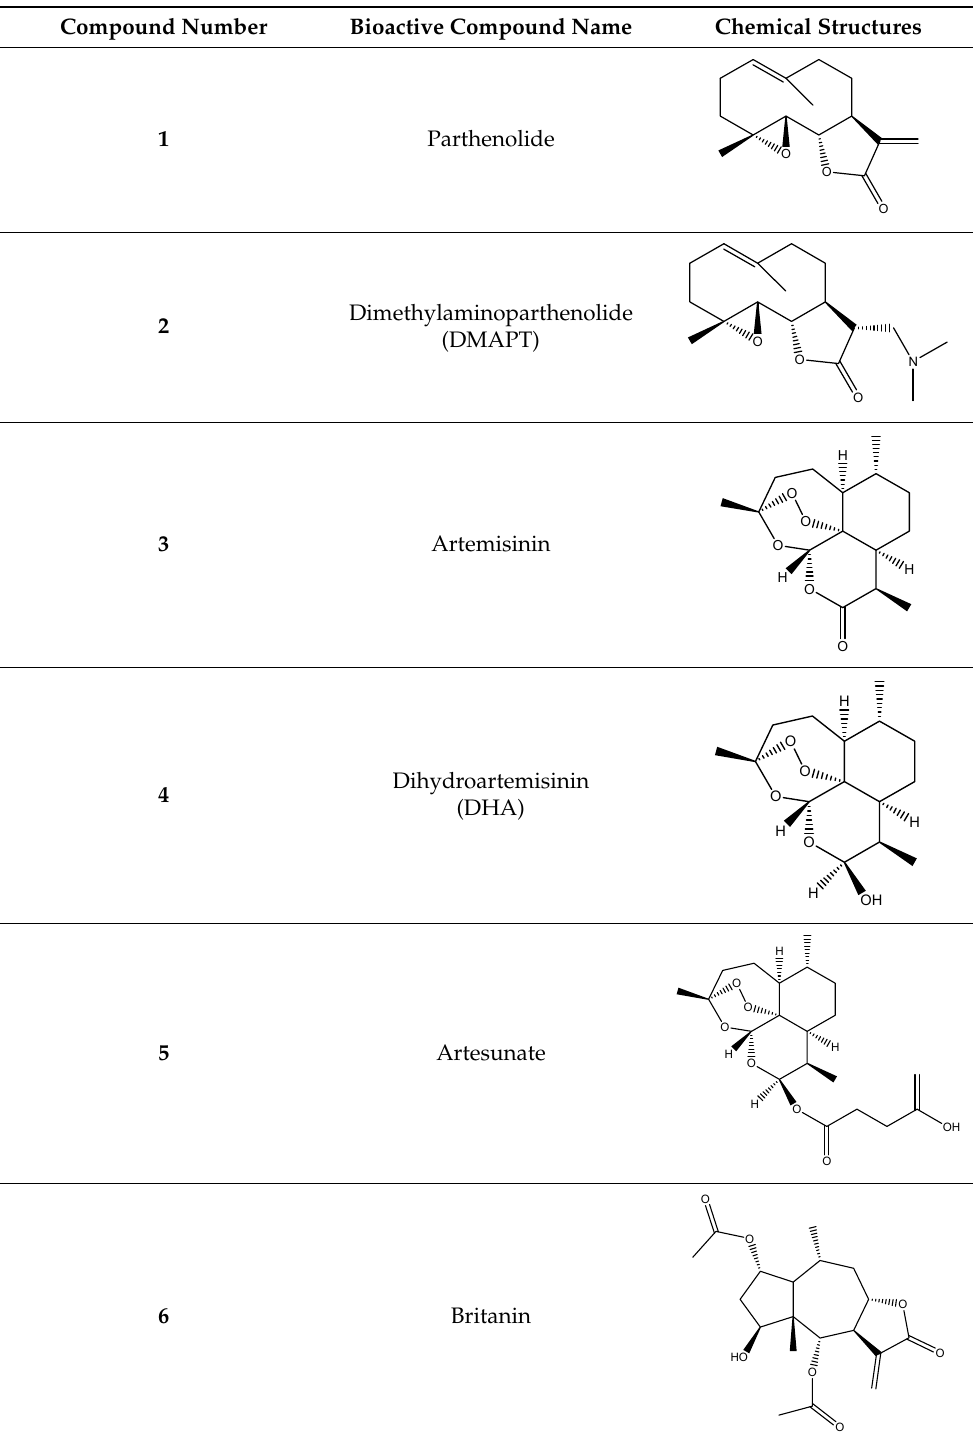
Table 1. Bioactive sesquiterpene lactones on KRAS pathways.